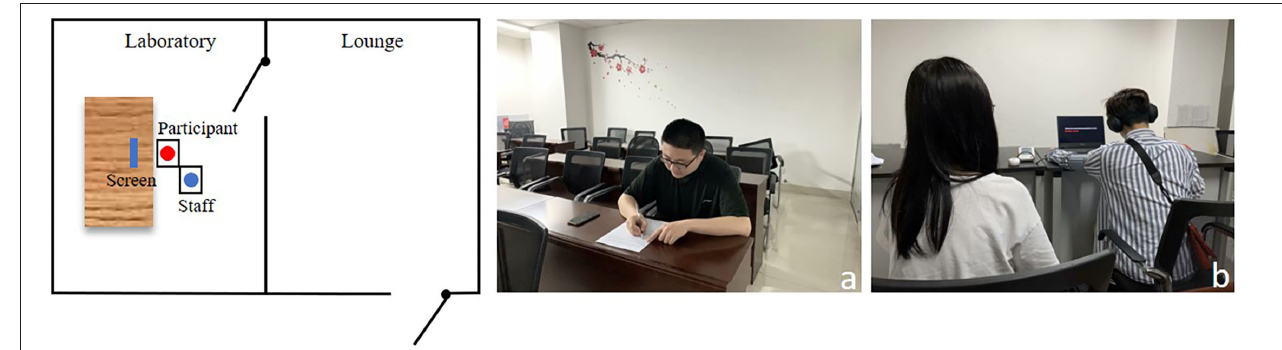
FIGURE 3 | Experimental scene [ (a) the participants was waiting in the waiting room to rest and fill in relevant information; (b) the experimenter is conducting the